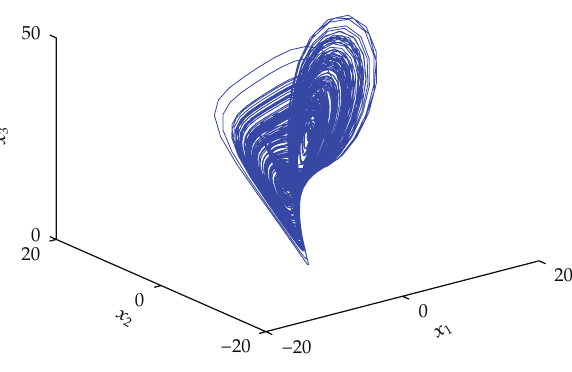
Figure 3: Chaotic attractors of the fractional-order Chen system (cid:2) 3.18 (cid:3) for q d (cid:7) 0 .